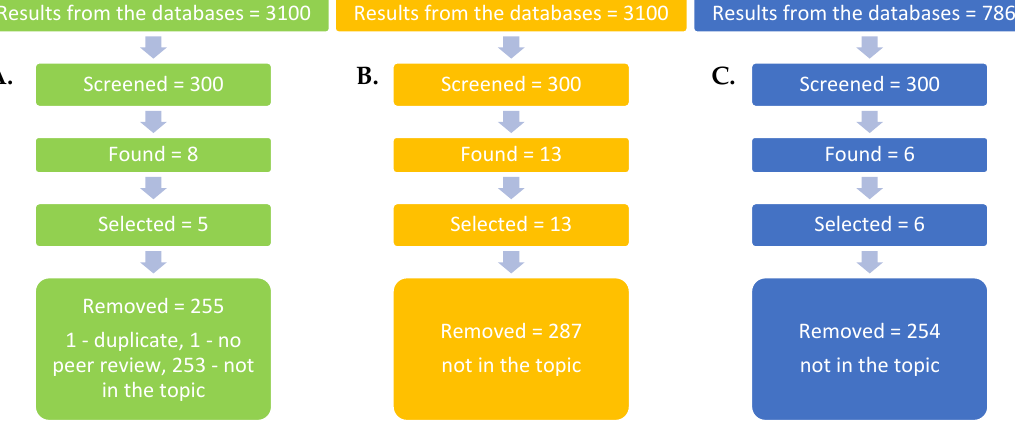
Figure 1. Literature research and article collection: ( A ) Echinacea cultivated with arbuscular mycor- rhiza for enhancing growth and secondary metabolite production. ( B ) Plants from Asteraceae family cultivated with arbuscular mycorrhiza for enhancing growth and secondary metabolite production.